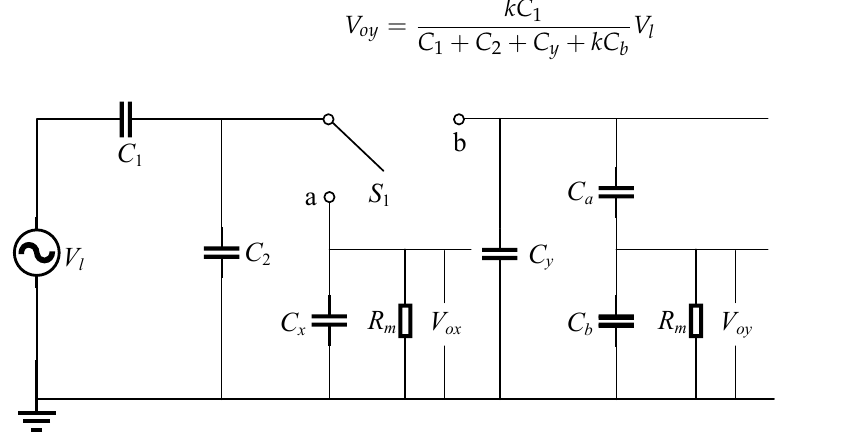
Figure 3. Optimized circuit topology.